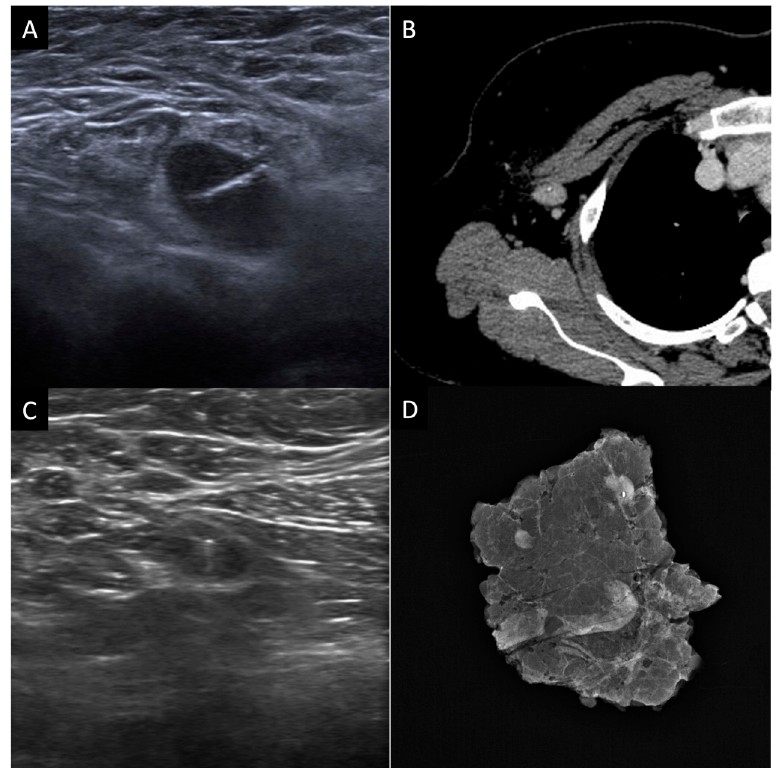
Figure 3. Selective axillary dissection technique (SAD): ( A ) ultrasound image of a clip marker placed in a histologically confirmed metastatic axillary lymph node before the beginning of NACT; ( B ) axial contrast enhanced CT image shows the clipped lymph node (CL); ( C ) ultrasound evaluation and identification of the CL before surgery; ( D ) surgical specimen radiograph to ensure that the CL has been removed along with the other lymph nodes.